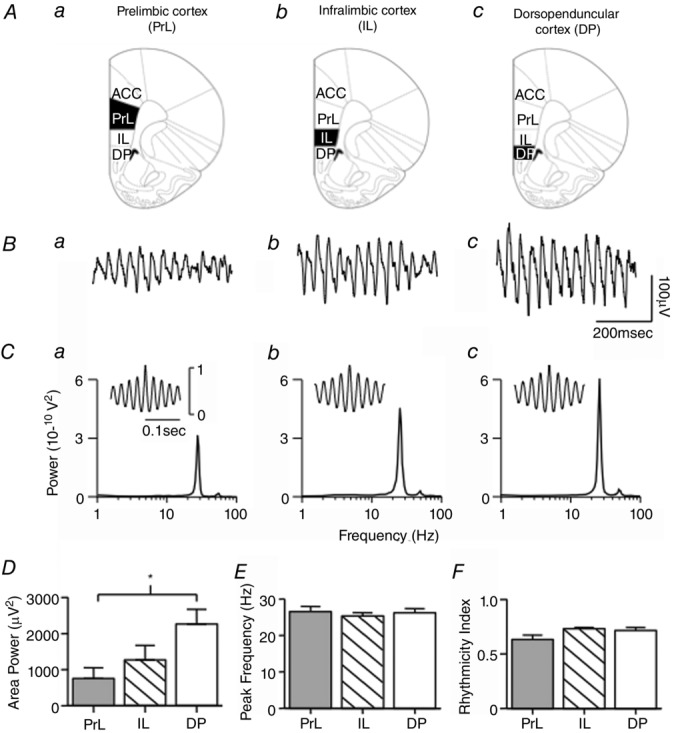
Comparison of fast network oscillations evoked in different subregions of the PFCA, schematic diagrams showing brain regions (black shading) used for prelimbic (PrL; a), infralimbic (IL; b) and dorsopeduncular (DP; c) cortex slices (interaural 11.70 mm). Adapted from Paxinos & Watson (2007). B, traces show 0.5 s epochs of extracellular field recordings showing fast network oscillations evoked by carbachol (10 μm) and kainate (200 nm) (Cb–KA) in the three subregions of mPFC. C, corresponding power spectra of 60 s of field recordings (insets show normalized autocorrelation of [−0.1–0.1] s). D–F, group data barplots of spectral and rhythmicity profiles of network oscillations in the mPFC. D, area power barplots show oscillations in PrL were significantly smaller than those in DP cortex (P < 0.05, one-way ANOVA, Tukey's test, n = 6). There was no significant difference in the frequency (E; P > 0.05, one-way ANOVA, n = 6) or the rhythmicity (F; P > 0.05, one-way ANOVA, n = 6) of the network oscillations between the three subregions.